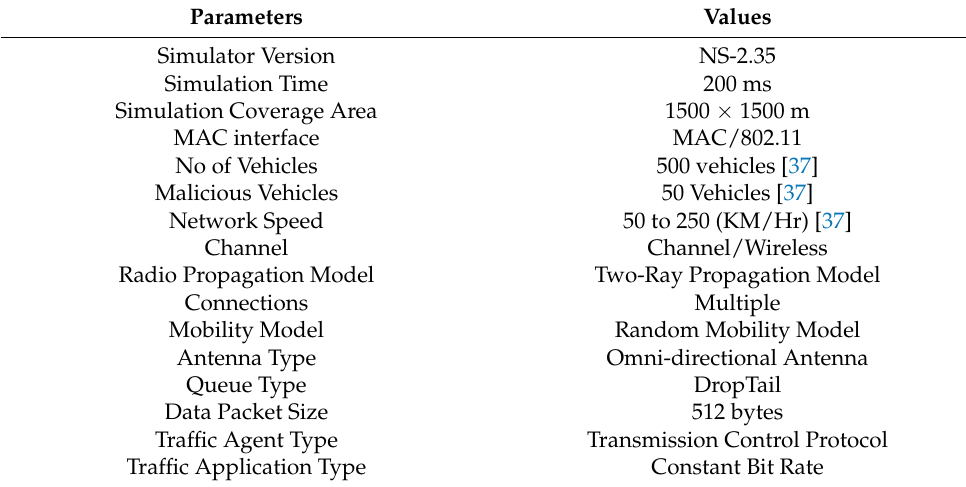
Table 6. Simulation Parameters.